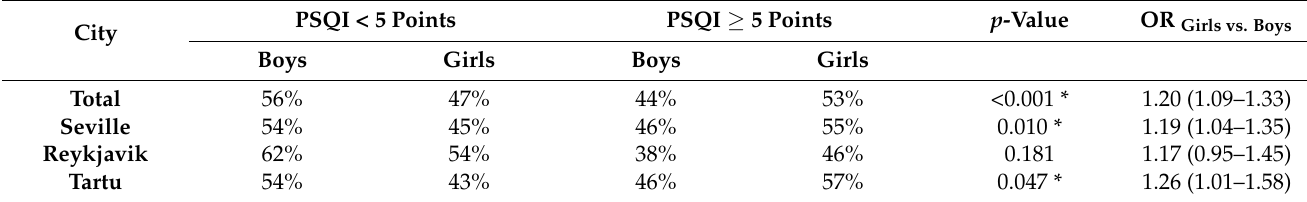
Table 5. Probability of having poor sleep quality in the three cities by